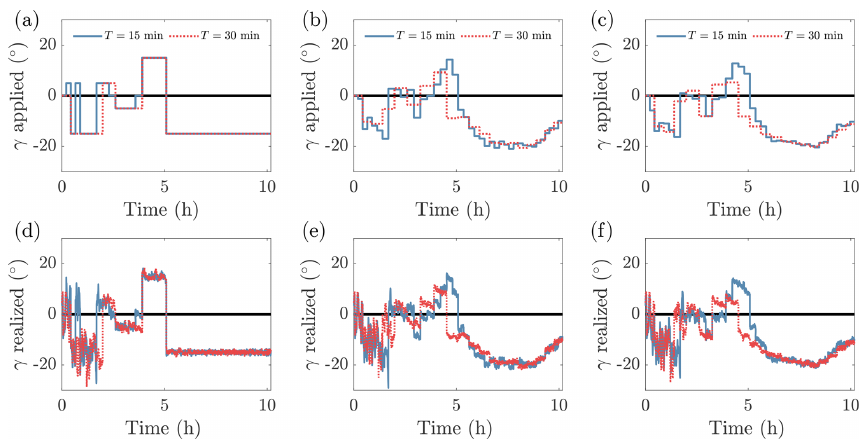
Figure 13. Comparison of the yaw misalignment set-point values as a function of time for turbine 1 from the (a) lookup table (Case L), (b) deterministic optimization (Case D–F), and (c) closed-loop control with optimization under uncertainty (Case OUU-F). (d–f) Same as (a–c) with realized yaw. Table 4. Wind farm energy production increase compared to baseline yaw-aligned control with T = 30 min; G = 100 · ( E r − 1) with E r in Eq. (6). Cases with α forecast use the DirectionEstimation algorithm. The case with the highest overall wind farm energy production is shown in bold. The full simulation period is considered, with stable, unstable, and transition regimes. Case Baseline, γ 0 Deterministic, α forecast OUU, α forecast Lookup table (open-loop) label Case A Case D–F Case OUU-F Case L T = 30min − 3 . 86% 4 . 00% 3 . 43% T = 15min 0 . 43% 3 . 82% 4 . 14 % 3 .